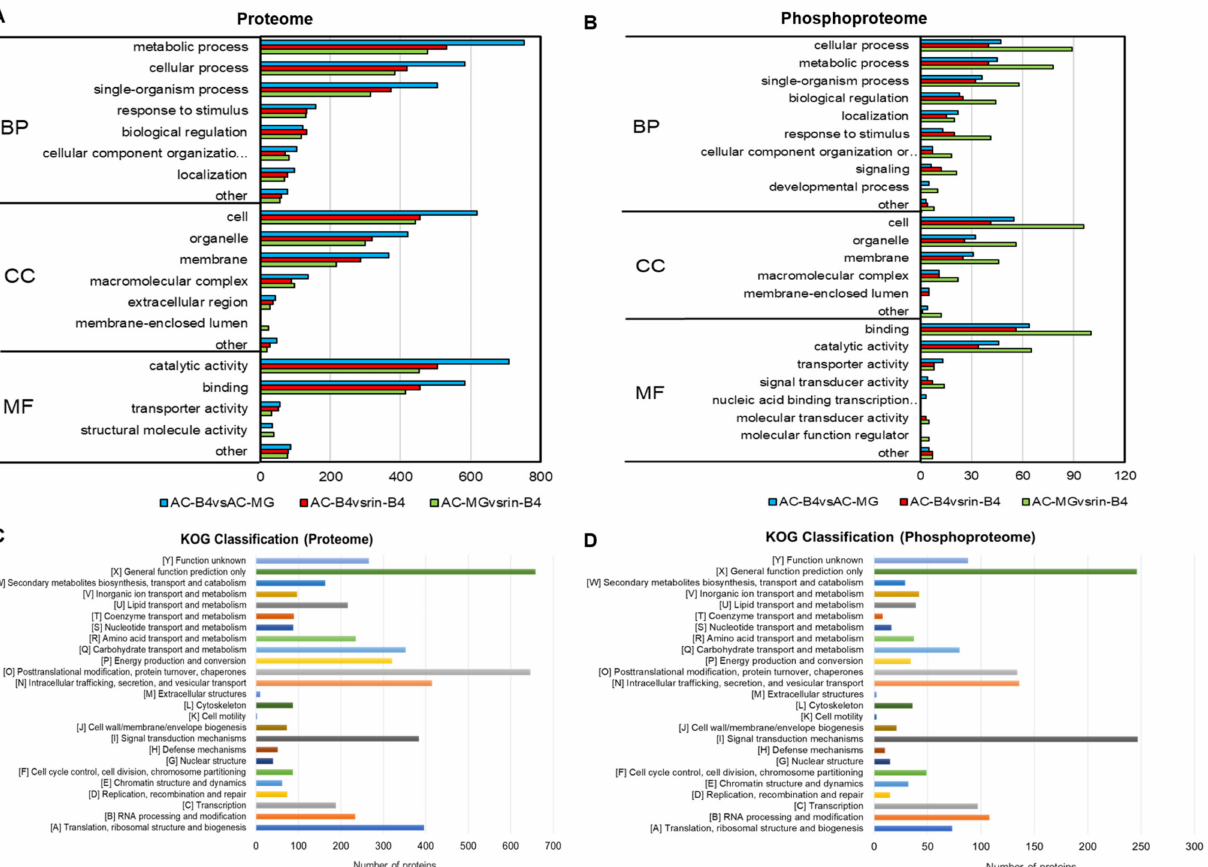
Figure 4. Top 20 GO categories and KOG classification assigned to the DEPs and DEPPs. Top 20 GO categories of the DEPs ( A ) and DEPPs ( B ). Top 20 KOG classification assigned to the DEPs ( C ) and DEPPs ( D ). BP, biological process; MF, molecular function; CC, cellular